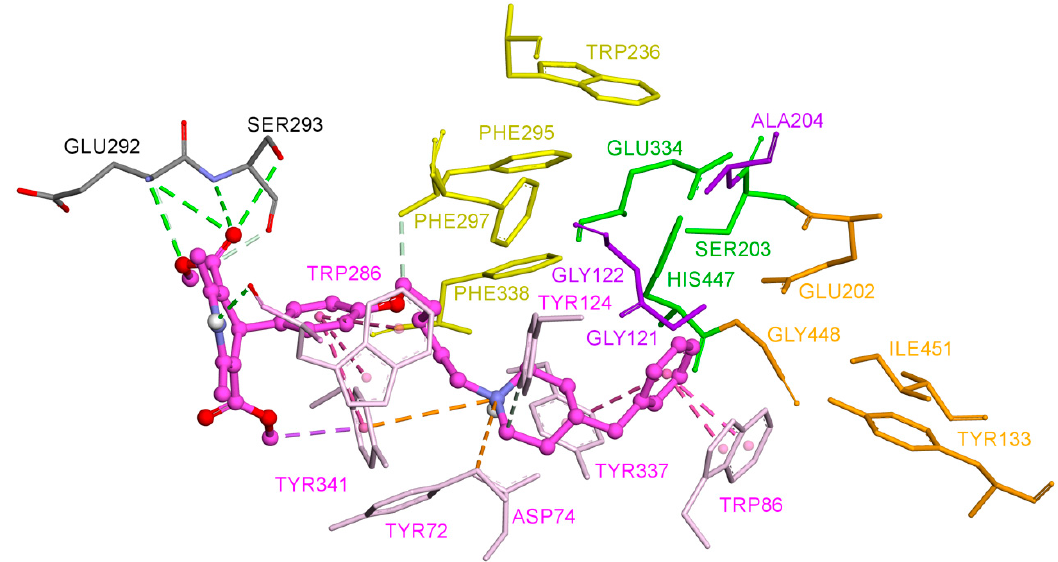
Figure 1. Binding mode of 3h in the active site of hAChE. Compound 3h is rendered as ball and stick (carbon atoms in pink) and the side chain conformations of the mobile residues are illustrated in light pink. The catalytic triad (CT) is colored in green, oxyanion hole (OH) in magenta, anionic subsite (AS) in orange, except Trp86, acyl binding pocket (ABP) in yellow and peripheral anionic site (PAS) in light pink. Hydrophobic contact, π – π stacking and π – π T-shaped were depicted in purple dot lines, H-bonds were in dark green dot lines, attractive charge and π –cation in orange and carbon hydrogen bond in light green dot lines.